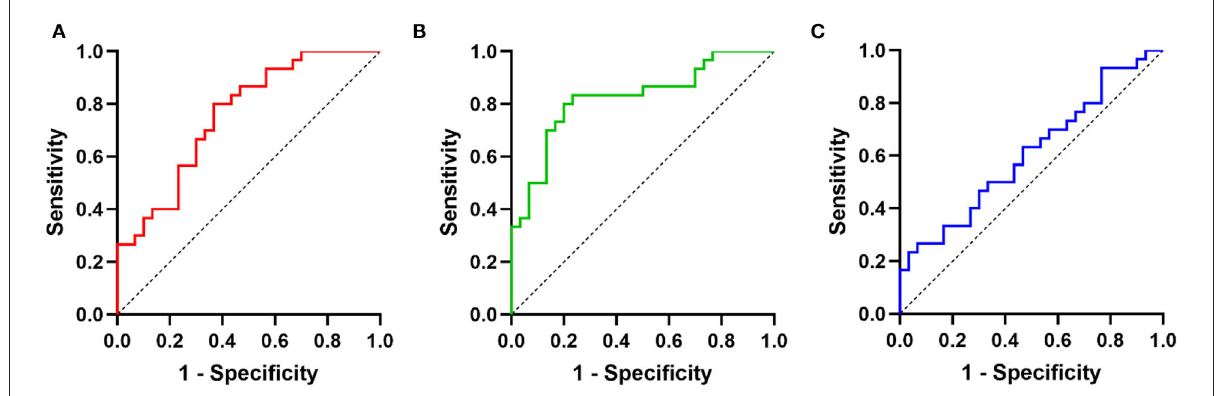
FIGURE2 The diagnostic value of three miRNAs for CAD-SCD: ROCs of (A) miR-126-5p; (B) miR-499a-5p; (C) miR-134-5p.